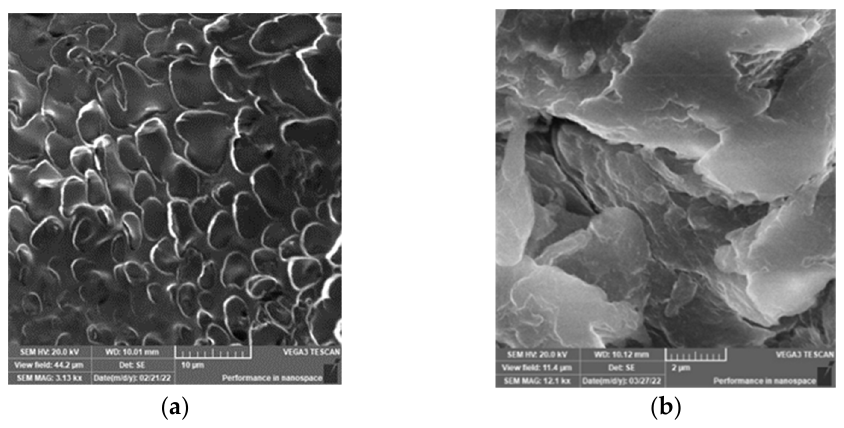
Figure 3. SEM Morphology of the superabsorbent ( b ) as compared to unmodified chitosan ( a ).